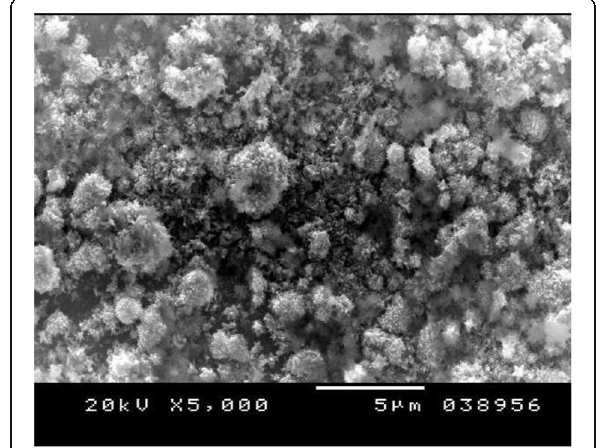
Fig. 5 Scanning electron microphotograph of Cp Titanium specimen coated with HA-Zn at